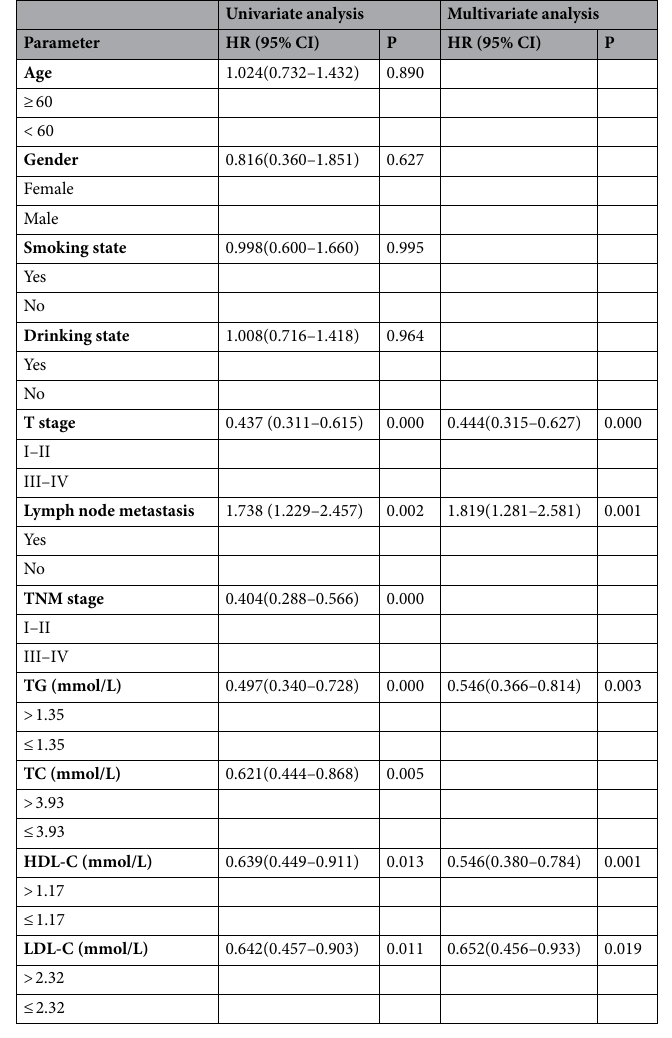
Table 6. Univariate and multivariate cox proportional analysis with overall